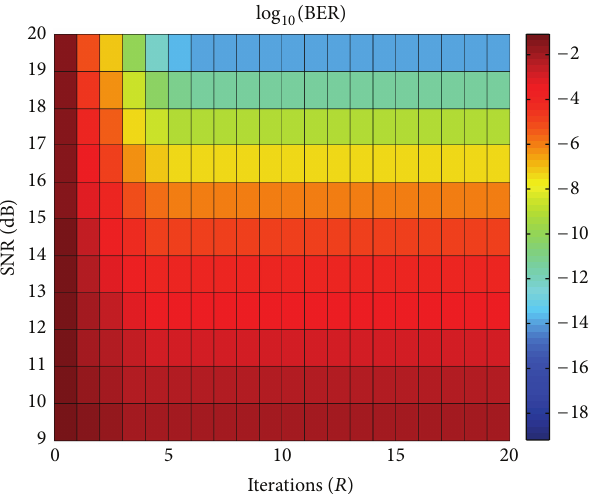
Figure 3: BER versus SNR and number of iterations. Postcursor channel with 𝛼 = 0.5/𝐿 = 6 .